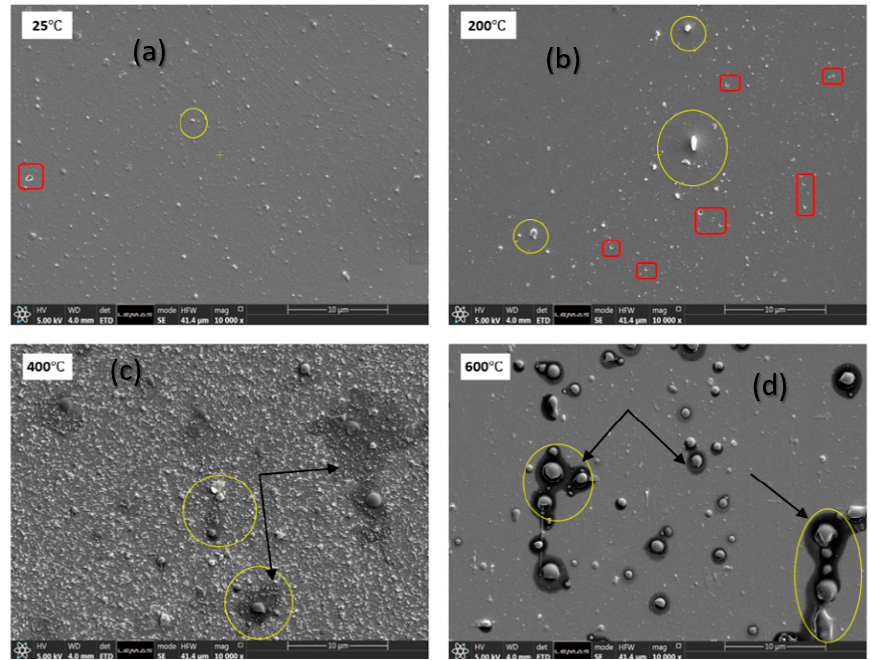
Figure 1. Top surface backscattered SEM mages of Ge-Se thin films deposited on a silicon substrate at various temperatures: ( a ) 25 °C, ( b ) 200 °C, ( c ) 400 °C, and ( d ) 600 °C. Cross-sections of the Ge-Se thin films deposited on/onto silicon were obtained via focused ion beam (FIB) lithography and examined on the transmission electron micro- scope (TEM). Figure 2a–d show TEM images of the cross-sections and selective area elec- tron diffraction pattern (SAED) patterns of the investigated Ge-Se thin films obtained us- ing FIB lithography. Figure 2a shows a closer view of the TEM image of the thin film de- posited at room temperature (25 °C), which displays a uniform cross-section of the Ge-Se layer sandwiched between the coated layer on top and pure silicon below. The cross-sec- tion of Ge-Se thin film looks darker than the silicon layer as Ge and Se are heavier elements than silicon. It is important to mention that the deposited layer is smooth without nano- particle clusters or defects. Nevertheless, as the substrate temperature increases from 25 °C to 200 °C, the TEM image (Figure 2b) shows occasional defects within the Ge-Se thin film layer. These defects may be composed of a different phase of Ge-Se. The TEM cross- sections of samples deposited at 400 °C and 600 °C indicate that higher substrate temper- atures have significant effects on film thickness and quality, as shown in Figure 2c,d. The plain view of TEM images reveals an average Ge-Se thin film thickness of ~400 nm for sample S25, ~150 nm for sample S200, and ~7 nm for samples S400 and S600. This finding indicates that the deposited material is volatile at higher temperatures and almost com- pletely disappears from the surface of the silicon substrate at 600 °C.